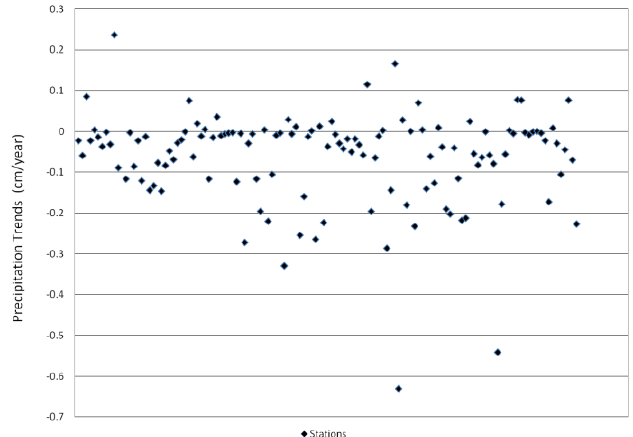
Figure 22. 1900–2007 precipitation trends by